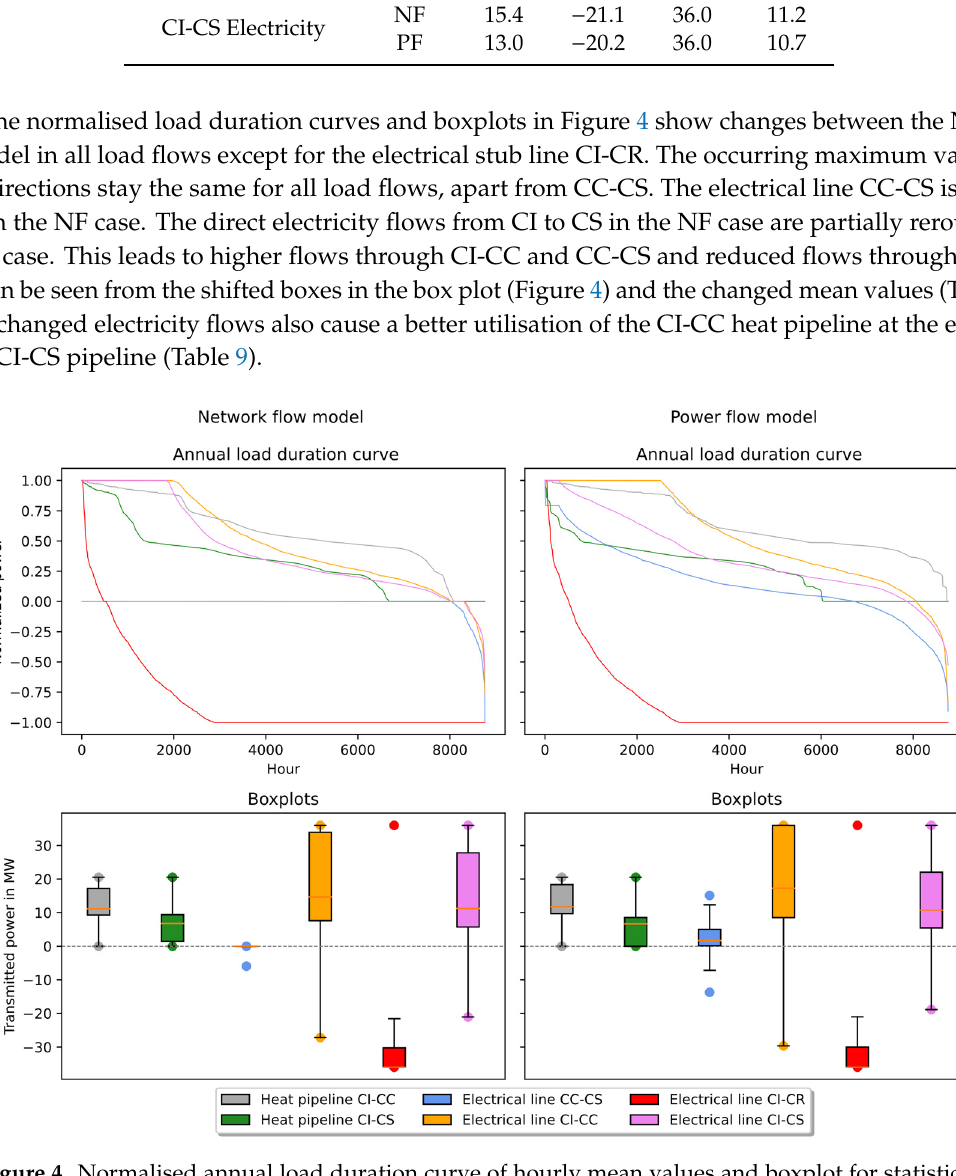
Figure 4. Normalised annual load duration curve of hourly mean values and boxplot for statistical analysis of the time series including maximum load flows in both directions.